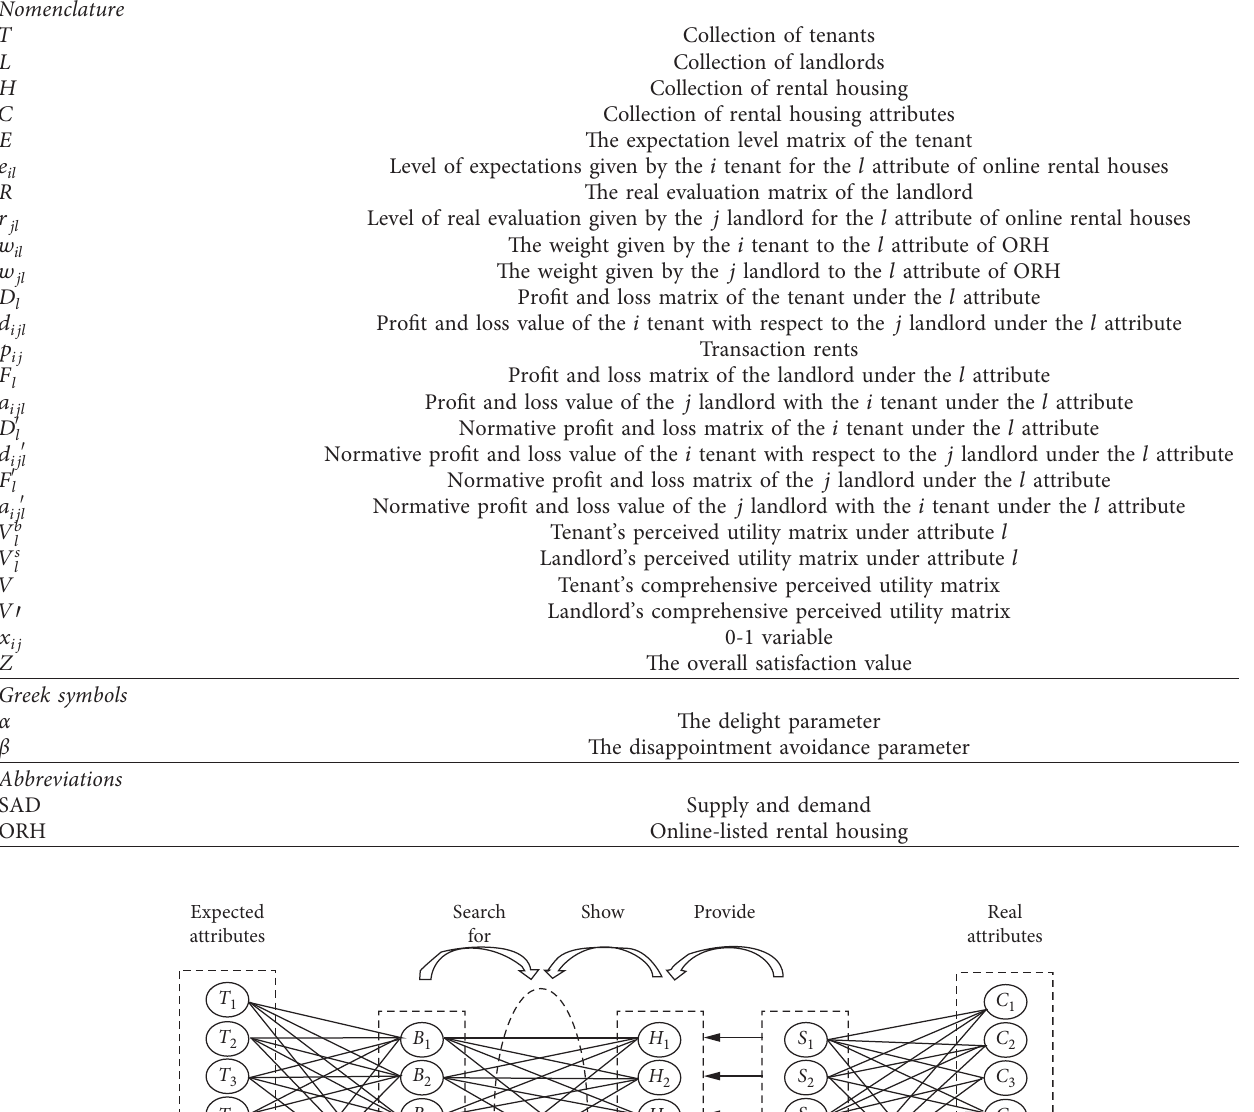
Table 1: Variable descriptions.